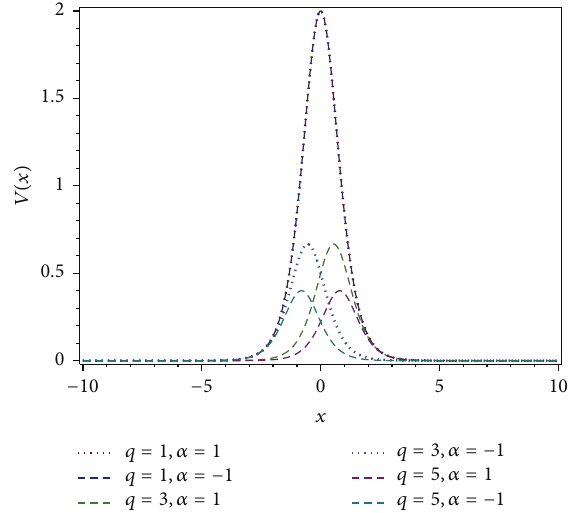
Figure 3: The plot of the qHPT potential as a function of position with 𝑞 = 1, 3, and 5 for 𝑥 < 0 and 𝑥 > 0, respectively.